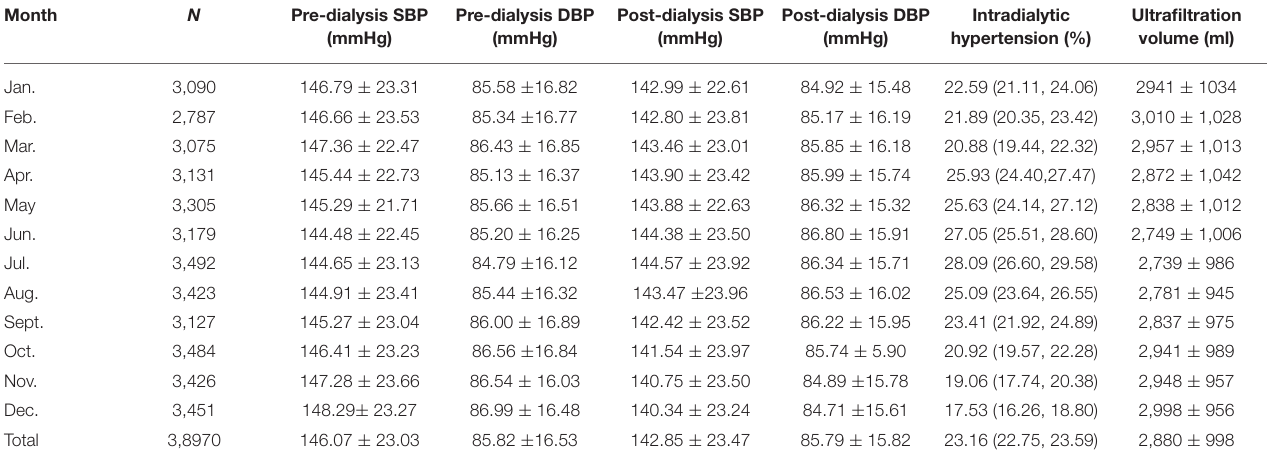
TABLE 1 | Pre-dialysis blood pressure (BP), post-dialysis BP, intradialytic hypertension, and hemodialysis (HD) ultrafiltration volume (UV) in patients receiving HD.